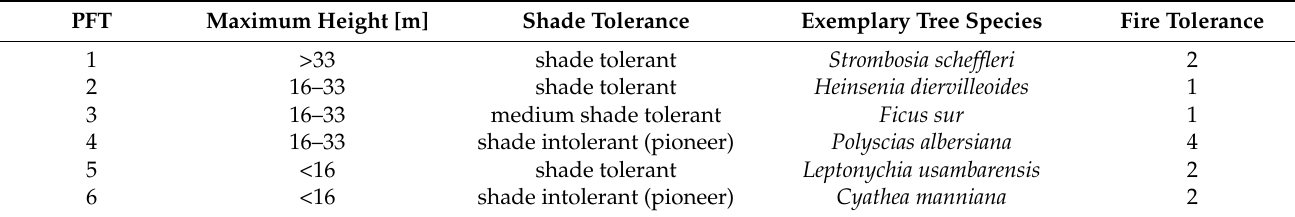
Table 2. Species grouping with fire tolerance at Mt. Kilimanjaro region. Grouping of all tree species in the study area into six species groups according to maximum height and shade tolerance (for full species list, see Appendix A). This species grouping into plant functional types (PFT) was already investigated in former studies [32,33]. In this study, only a fire tolerance was assigned to each species